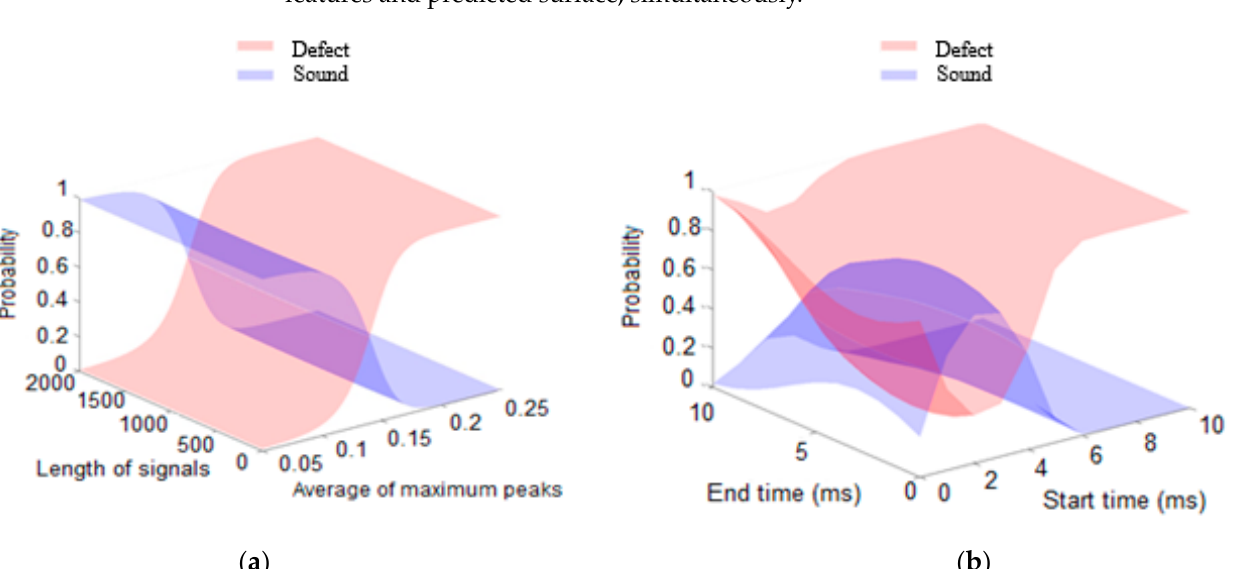
Figure 11. Probability surface to detect defect and sound based on the feature of preprocessed IE signals’ ( a ) length of signals and average of maximum peaks, ( b ) start and end time.